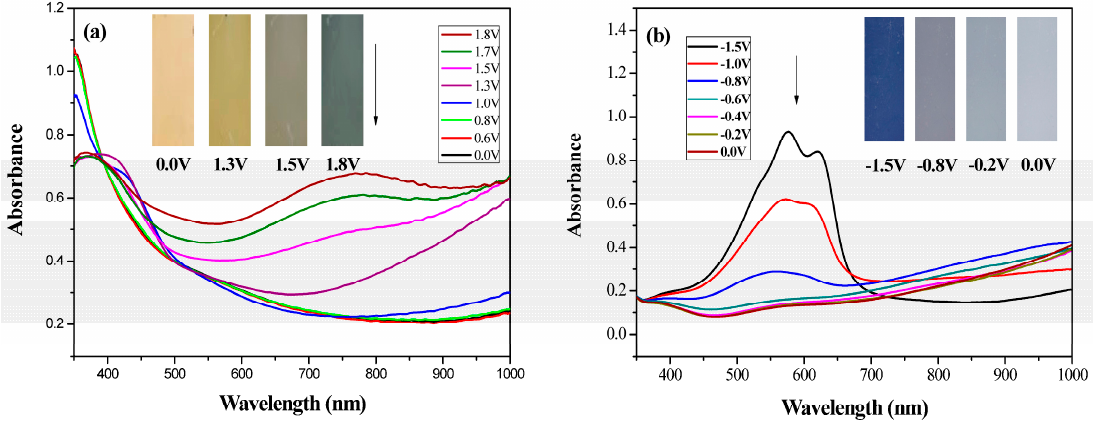
of the PtCz and PProDOT-Me 2 films at various potentials were shown in Table 2.